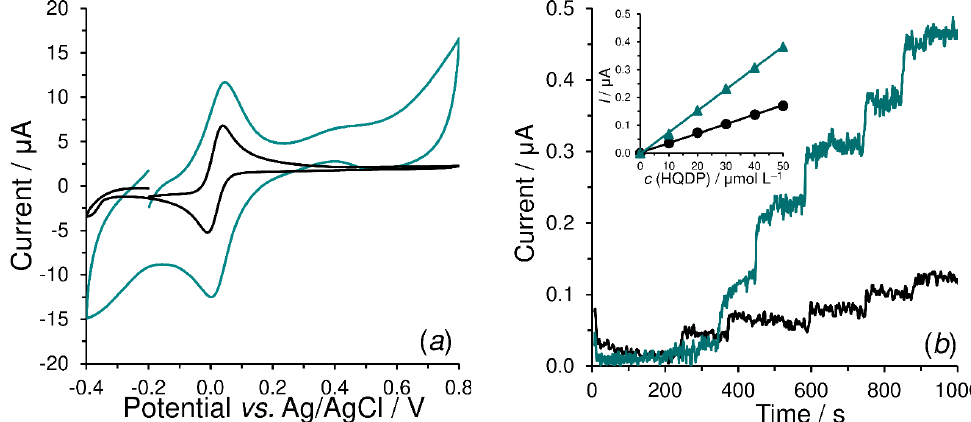
Figure 10. Cyclic voltammograms of 500 μmol L −1 hydroquinone obtained at SPCE (black) and SPCE/P4HB (deep green curve) in 0.1 mol L −1 CBB with 0.1 mol L −1 KCl (pH 9) at a scan rate of 10 mV s −1 ( a ). Amperograms (for batch configuration) of 10 μmol L −1 HQDP (five subsequent injections, n = 5) obtained at SPCE/ALP-GTA (black) and SPCE/P4HB-ALP-GTA (blue curve) in 0.1 mol L −1 CBB with 0.1 mol L −1 KCl content (pH 9) at working potential of +0.1 V and stirring speed of 400 rpm ( b ).